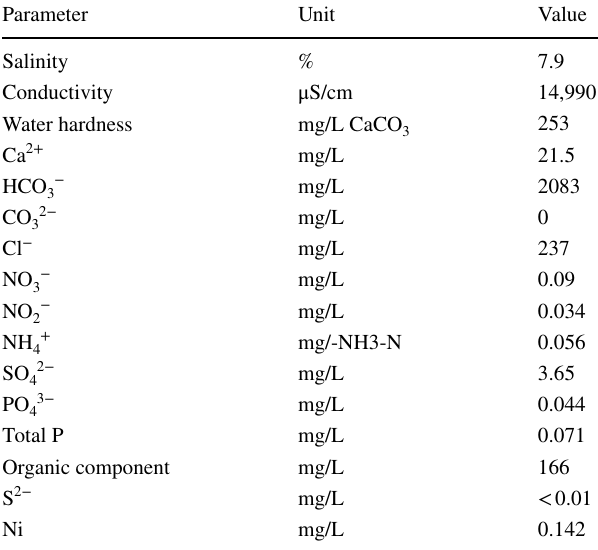
Table 2 Physicochemical characteristics of the formation